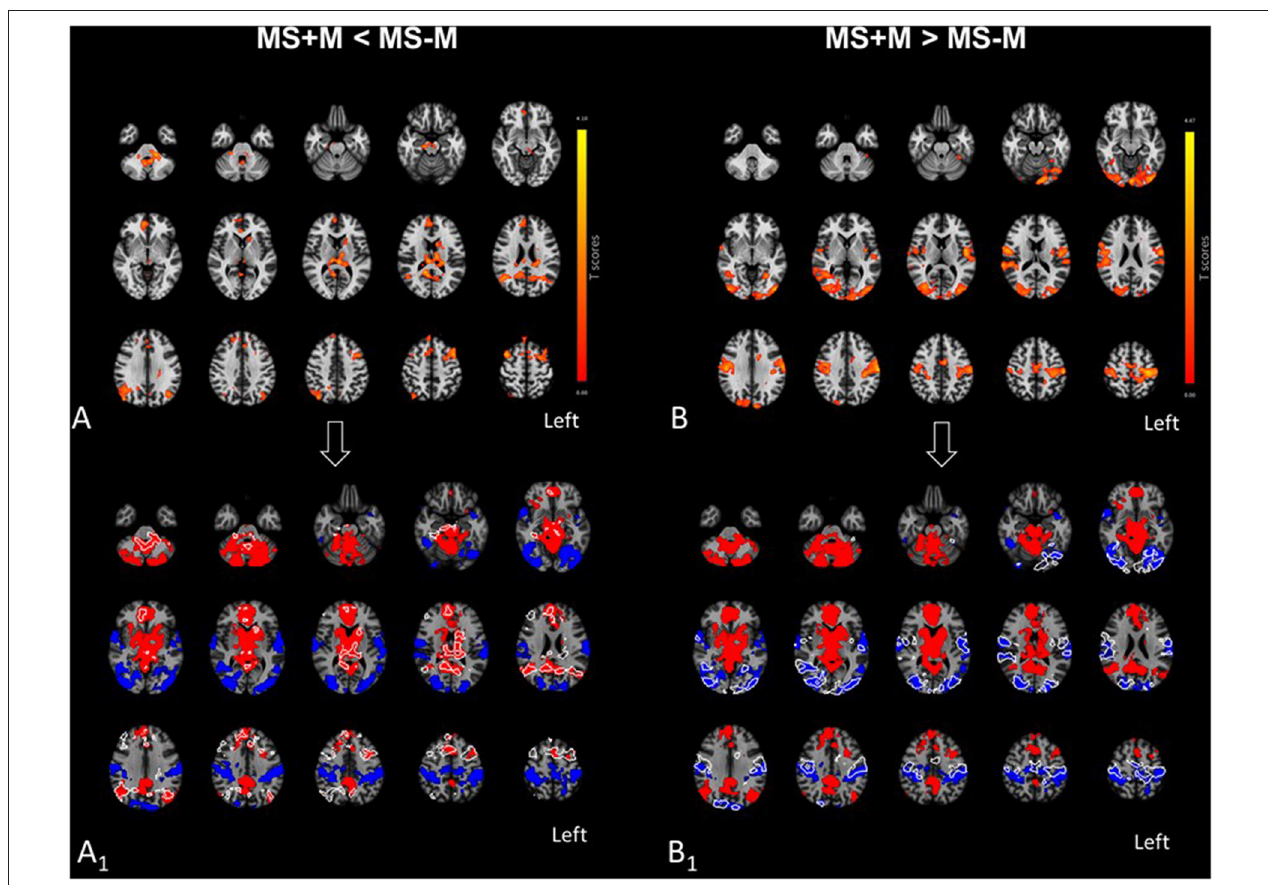
FIGURE 2 | Effect of migraine on the PAG functional organization outside pain episodes, in patients with MS. In the upper panel, (A,B) show the areas where MS + M patients exhibited reductions and increases of PAG connectivity as compared to MS-M patients, respectively. In the lower panel, (A 1 ,B 1 ) provide white outlines of the clusters respectively shown in (A,B) , in comparison with the positive and negative PAG RS-FC of MS-M patients. Outlines are overlaid on the same MS-M and MS + M PAG connectivity maps of MS-M patients which were presented in Figure 1A . In (A 1 ) , connectivity reductions in MS + M patients [outlines in (A 1 ) ] corresponded to areas where MS-M patients were positively connected with the PAG, thus suggesting a loss of functional integration in MS + M. In contrast, connectivity increases in MS + M [outlines in (B 1 ) ] developed in areas where MS-M patients were negatively connected (underlying blue clusters), possibly suggesting a loss of functional segregation with respect to MS-M. Results are presented at the statistical threshold of P = 0.05, FDR-corrected, in radiological convention, and overlaid on a standard MNI template for anatomical